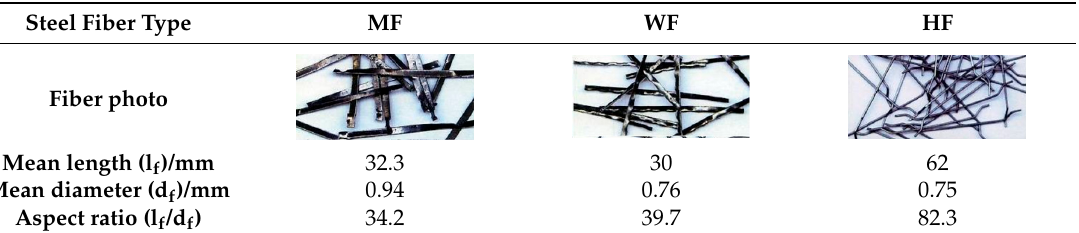
Table 2. Photos and characteristics of steel fibers.